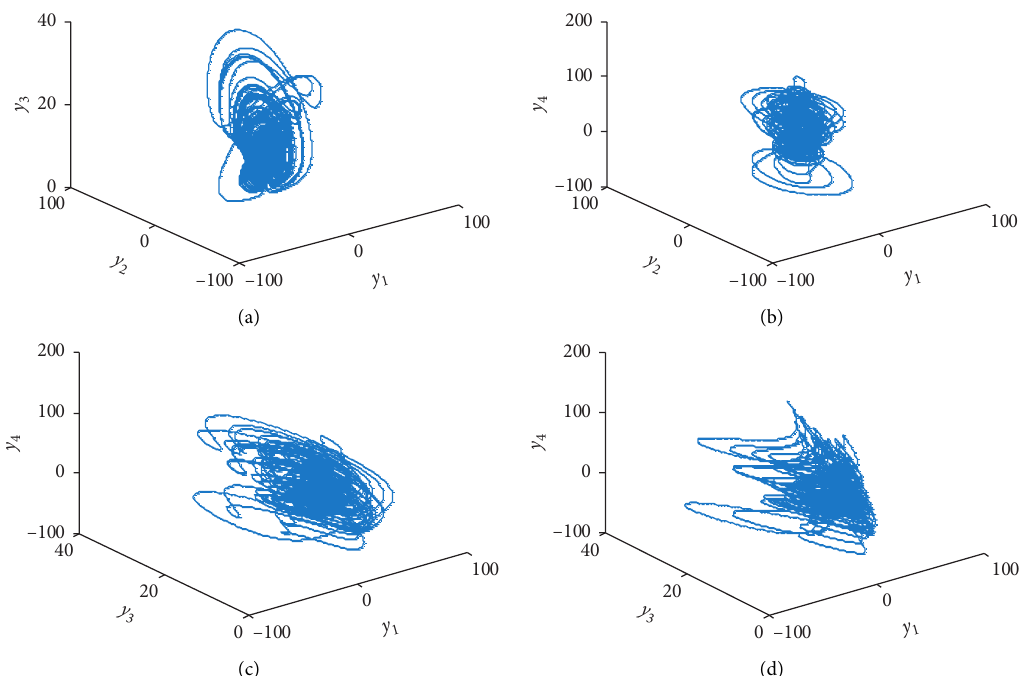
, y , y ) space; (b) projection in 1 2 3